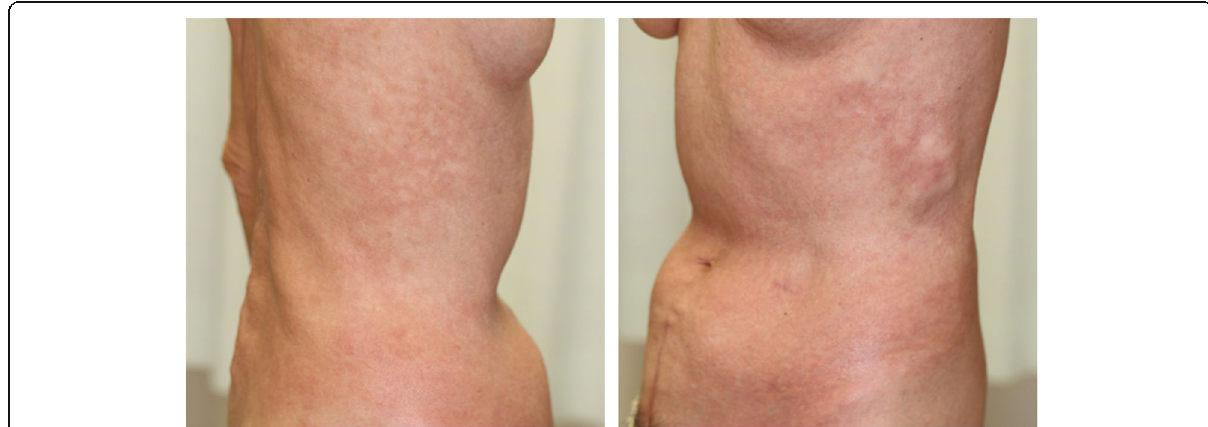
Fig. 1 A picture on admission showing rash around the abdomen